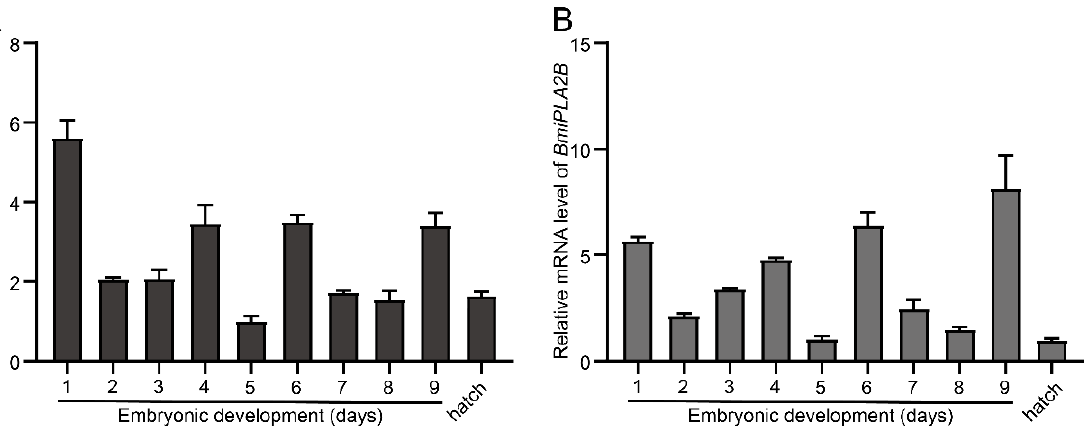
Figure 6. The temporal expression profiles BmiPLA2A ( A ) and BmiPLA2B ( B ) in embryonic developmental stages.